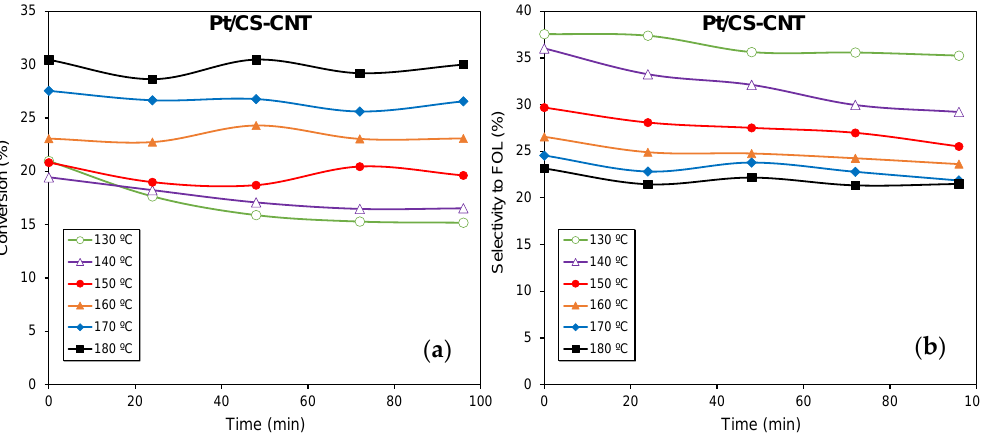
Figure 6. Evolution of the catalytic performance as a function of time on stream over the Pt-catalyst supported on the glucose-carbon nanotube hybrid (Pt/CS-CNT): ( a ) conversion of FUR and ( b ) selectivity to FOL.